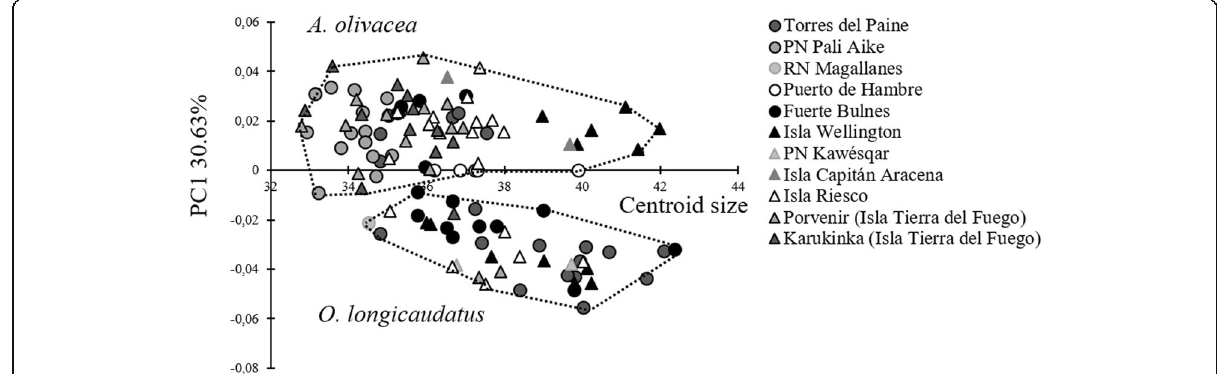
Fig. 6 Range values of cranial size (centroid size) of individuals along shape axis (PC1 scores) for the two species: A. olivacea and O. longicaudatus. PN = Parque Nacional, RN = Reserva Nacional, circles = mainland localities, triangles= insular